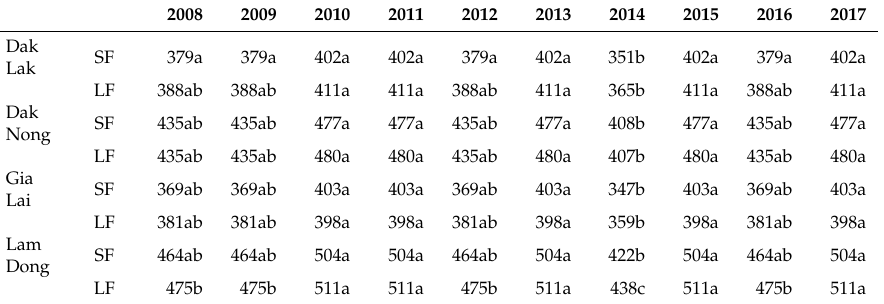
Table 4. Comparison of nitrogen rates (N kg ha − 1 ) between years according to the farm size in Vietnamese Robusta co ff ee-producing provinces. Number with similar letter in a given row are not statistically di ff erent ( p > 0.05). SF: small-scale farms; LF: large-scale farms.